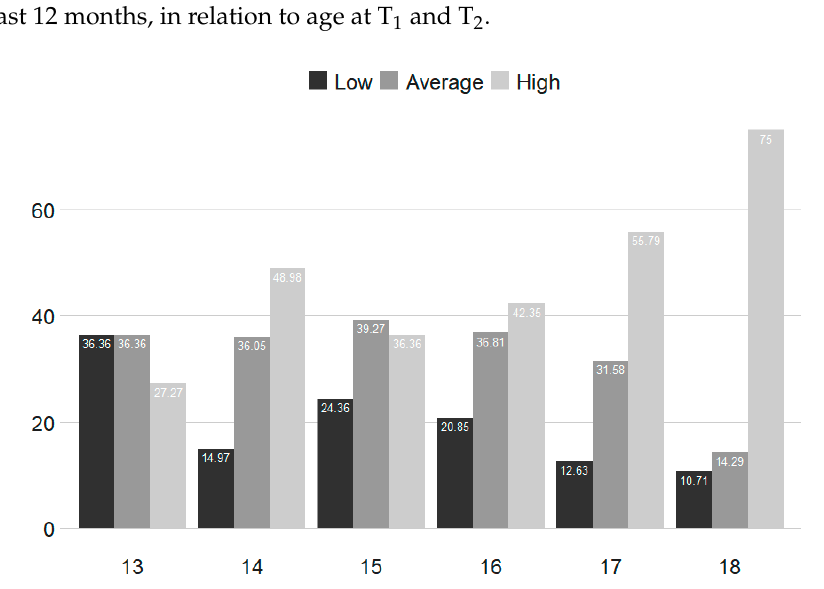
Figure 1. Gambling frequencies by age (%) for T 1 ( n = 774 individuals who gambled within the past 12 months).